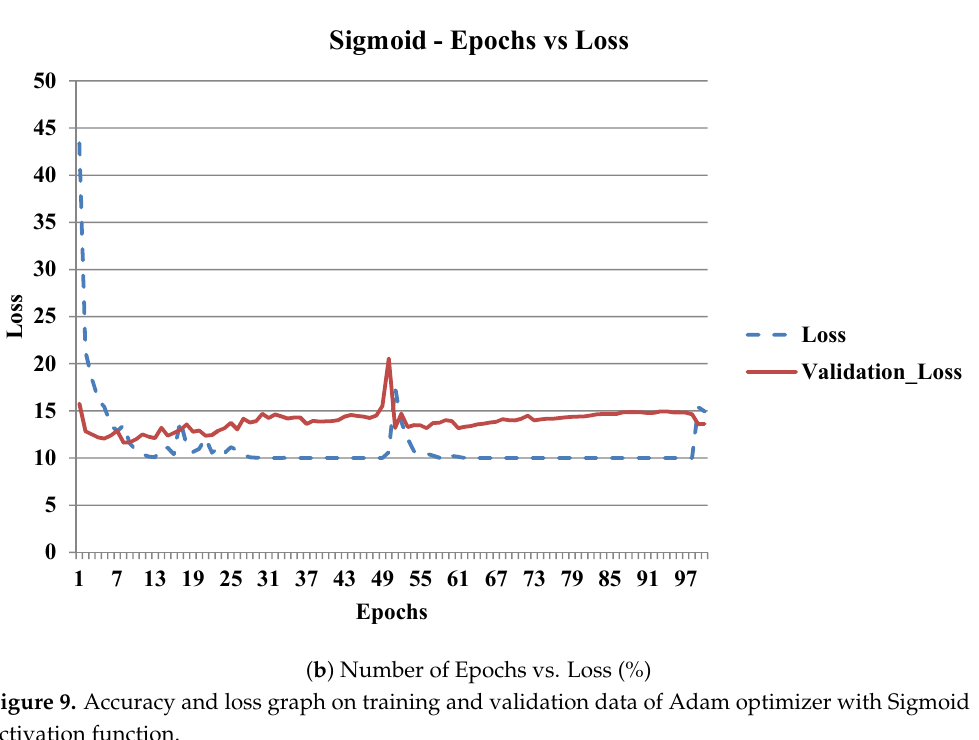
Figure 9. Accuracy and loss graph on training and validation data of Adam optimizer with Sigmoid activation function.